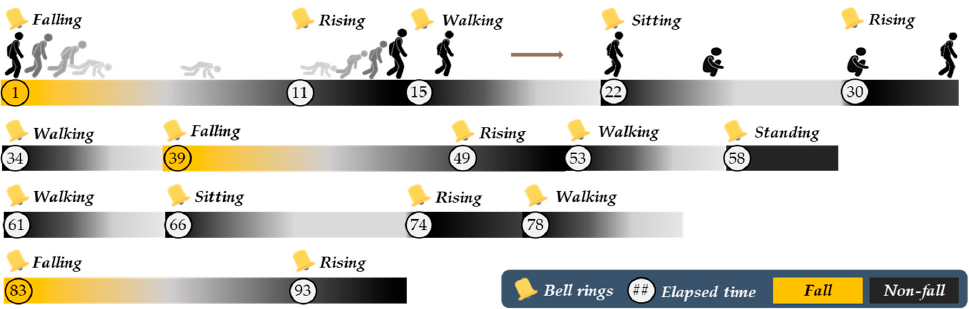
Figure 11. Scenario for building a database for creating a fall/activities of daily living (ADL) classification model.